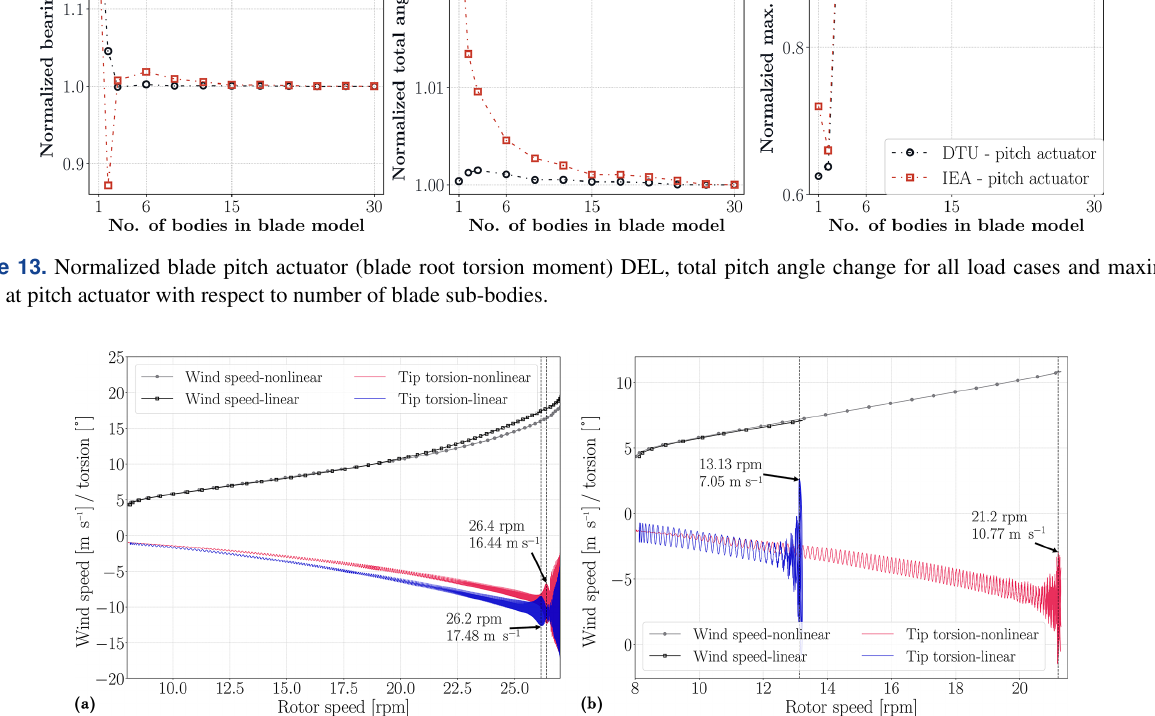
Figure 14. DTU10MW (a) and IEA (b) rotor speed and blade tip torsion deformation results with respect to wind speed. The flutter wind speeds are shown in the